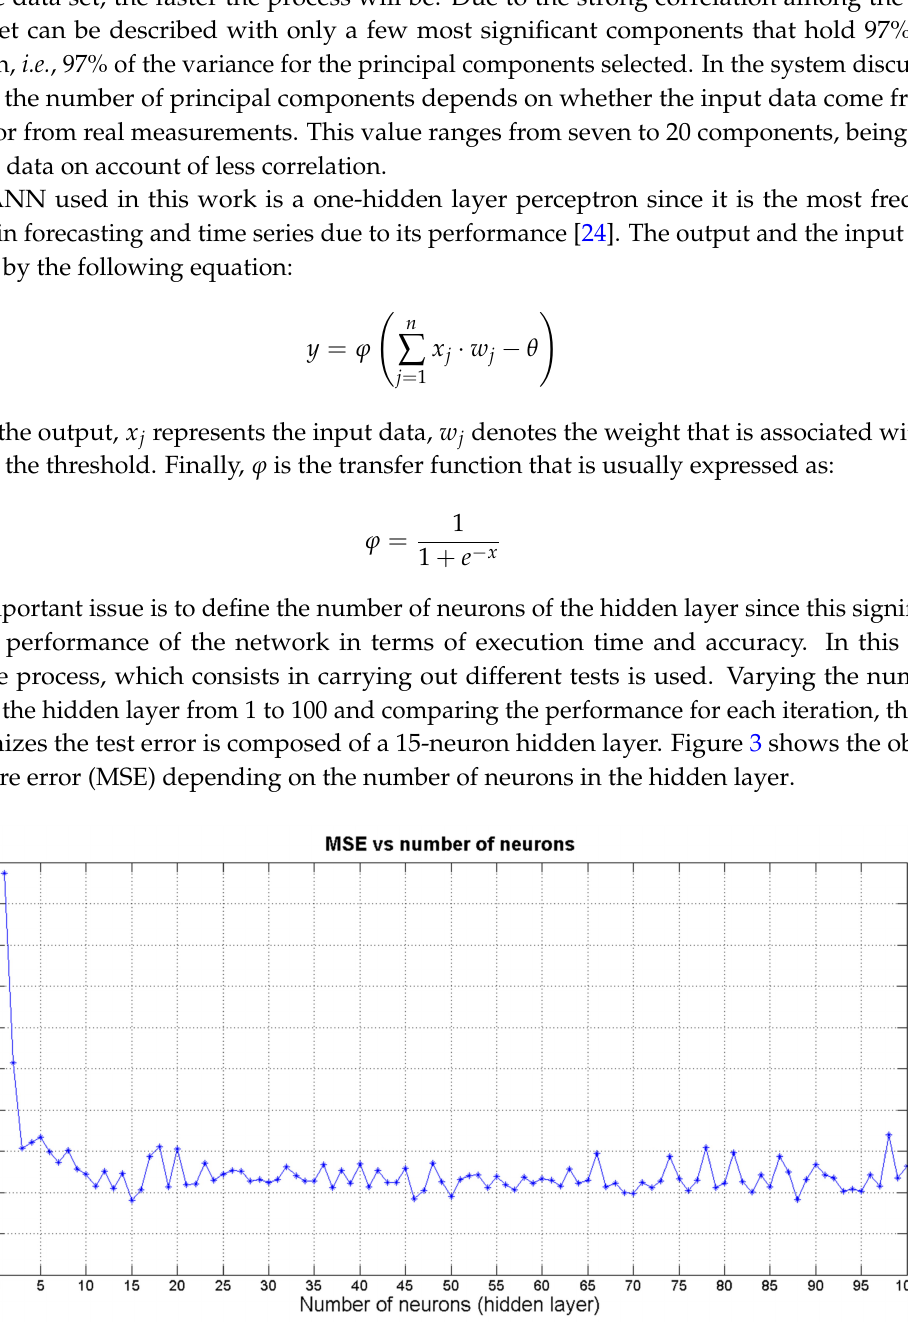
Figure 3. MSE depending on the number of